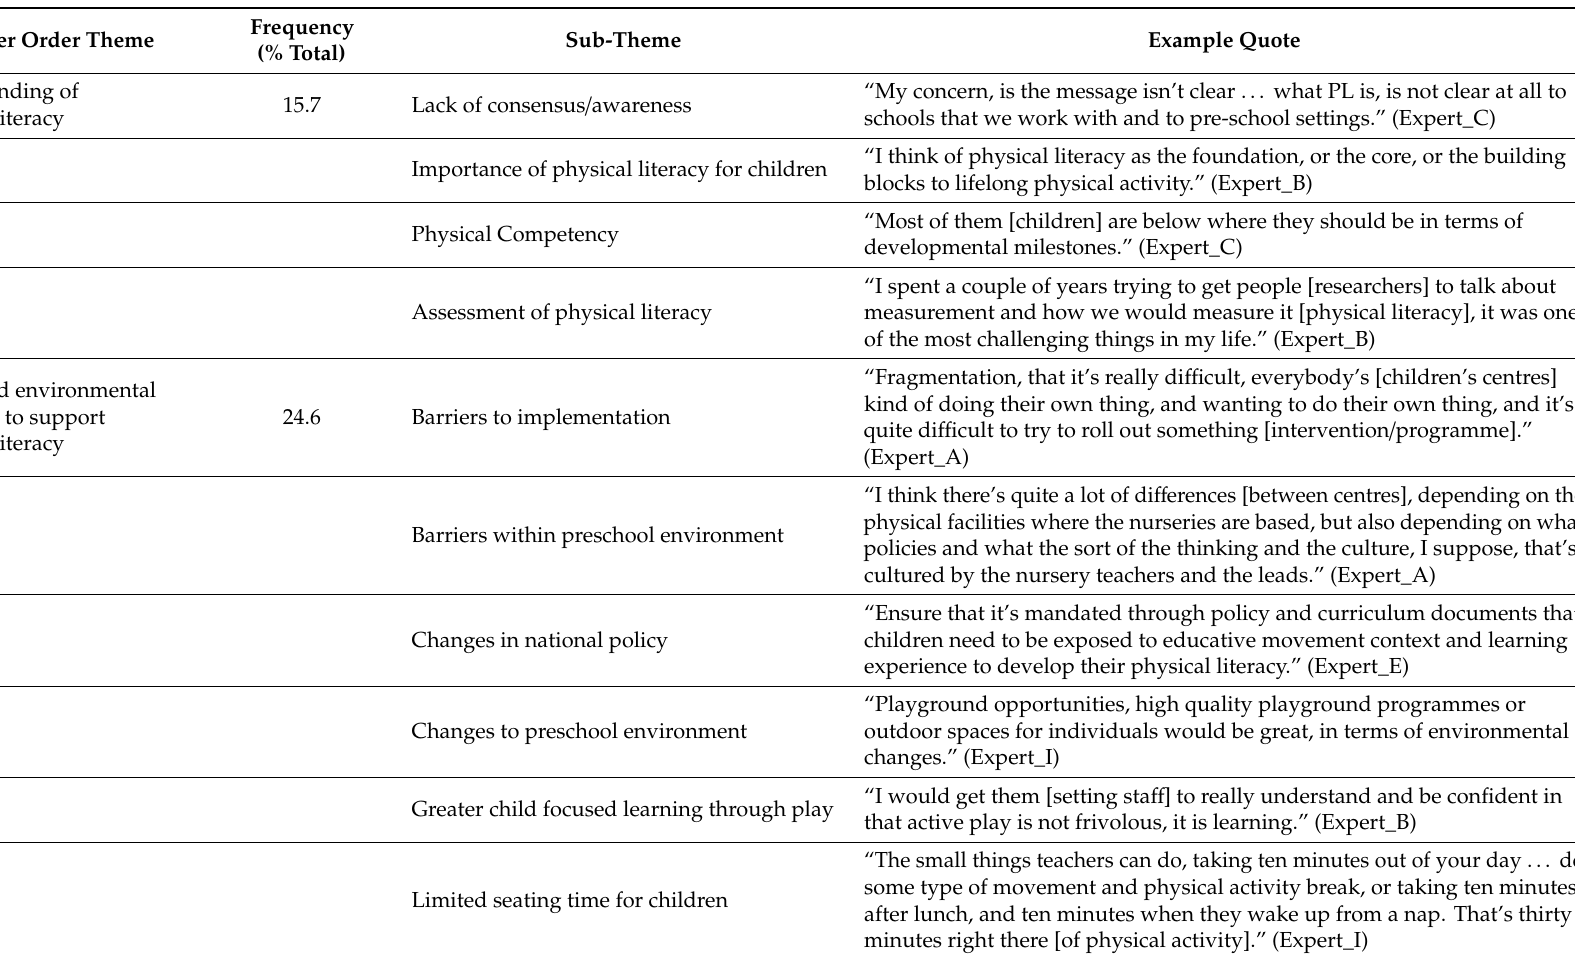
Table 1. Summary of higher order themes and emergent sub-themes (minimum consensus of ≥ 3 participants from Phase One interviews with